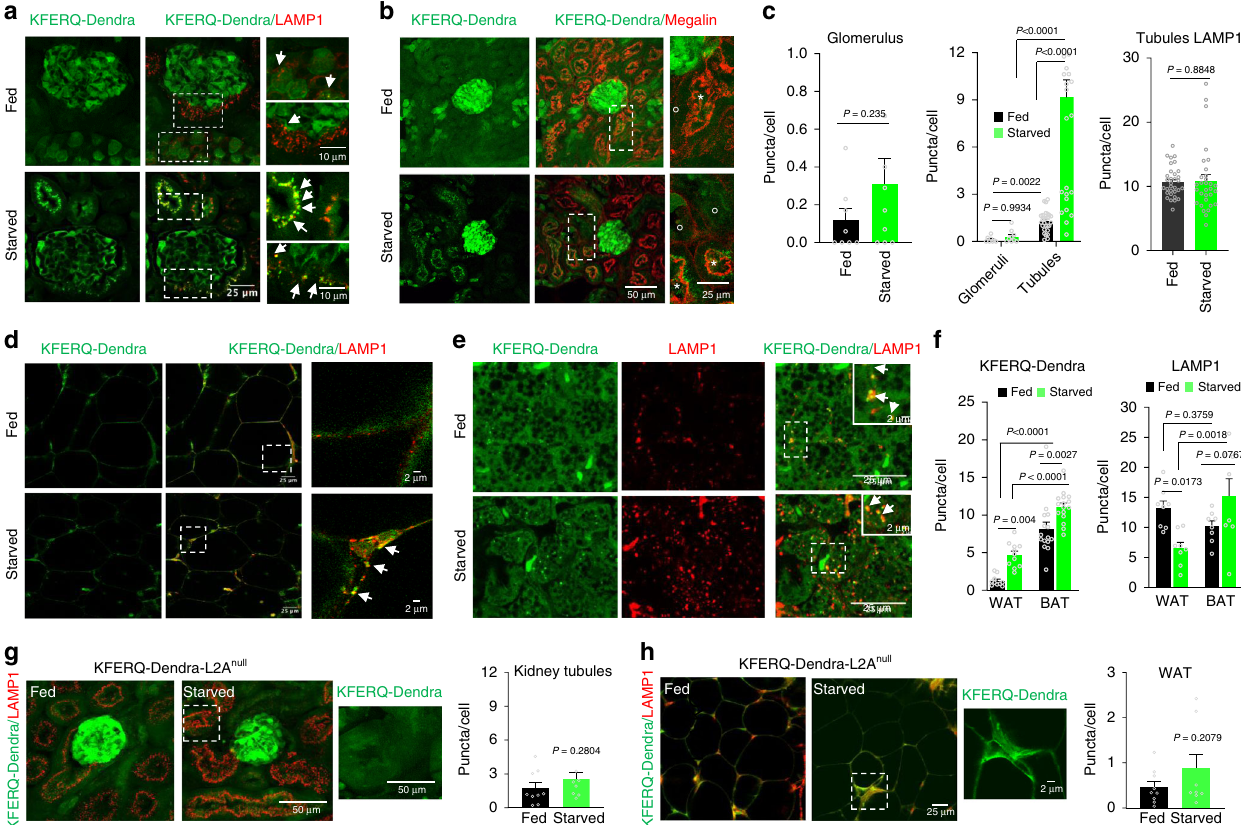
Fig. 2 Tissue-speci fi c changes in CMA in response to starvation. CMA (measured as number of fl uorescent puncta per cell) in sections from kidney ( a – c ) and white and brown adipose tissue ( d – f ) of fed or 24 h starved KFERQ-Dendra mice. a , b Green KFERQ-Dendra fl uorescence in kidney immunostained for LAMP1 ( d ) or Megalin ( e ) to stain proximal tubules. Megalin positive (star) and negative (circle) tubules and LAMP1 puncta positive for Green Dendra fl uorescence (arrows) are shown. c Changes in Dendra-positive puncta in glomerulus (left) or glomerulus compared with tubules (middle) and in LAMP1 staining in tubules (right). Dendra values are from n = 8 (fed glomeruli), 9 (starved glomeruli), 27 (fed tubules) and 29 (starved tubules) sections coming from three independent experiments and LAMP1 values are from n = 32 (fed tubules) and 31 (starved tubules) sections from the same experiments. d , e Green KFERQ-Dendra fl uorescence in white (WAT, d ) and brown (BAT, e ) adipose tissue immunostained with LAMP1. Arrows: LAMP1 and Green Dendra fl uorescence positive puncta. f Dendra-positive puncta (left) and LAMP1 puncta (right) in WAT and BAT in fed and starved mice. Dendra values are from 10 (fed WAT), 11 (starved WAT), 15 (fed BAT) and 10 (starved BAT) sections coming from three independent experiments and LAMP1 values from 8 sections from all conditions from the same experiments. g , h KFERQ-Dendra fl uorescence in kidney ( g ) and WAT ( h ) from fed or starved for 24 h KEFRQ-Dendra and KFERQ-Dendra-L2A null mice immunostained with LAMP1. Inset: green channel of boxed area. Right: Dendra-positive puncta quanti fi cation from 9 sections of each organ and condition coming from four independent experiments. Insets show boxed areas at higher magni fi cation. Data are presented as mean values ± s.e.m. Two-tailed unpaired t -tests ( c right and left, g , h ) and two-way ANOVA test followed by Sidak ’ s multiple comparisons tests (Fig. 2 c middle and f ) were used. Source data are provided in the Source Data fi